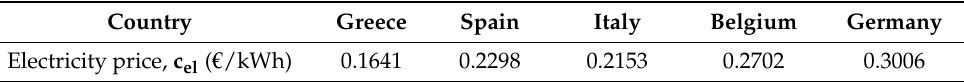
Table 9. Electricity prices for private household consumers in the selected countries for 2020 ( € /kWh) based on data from Eurostat [85].